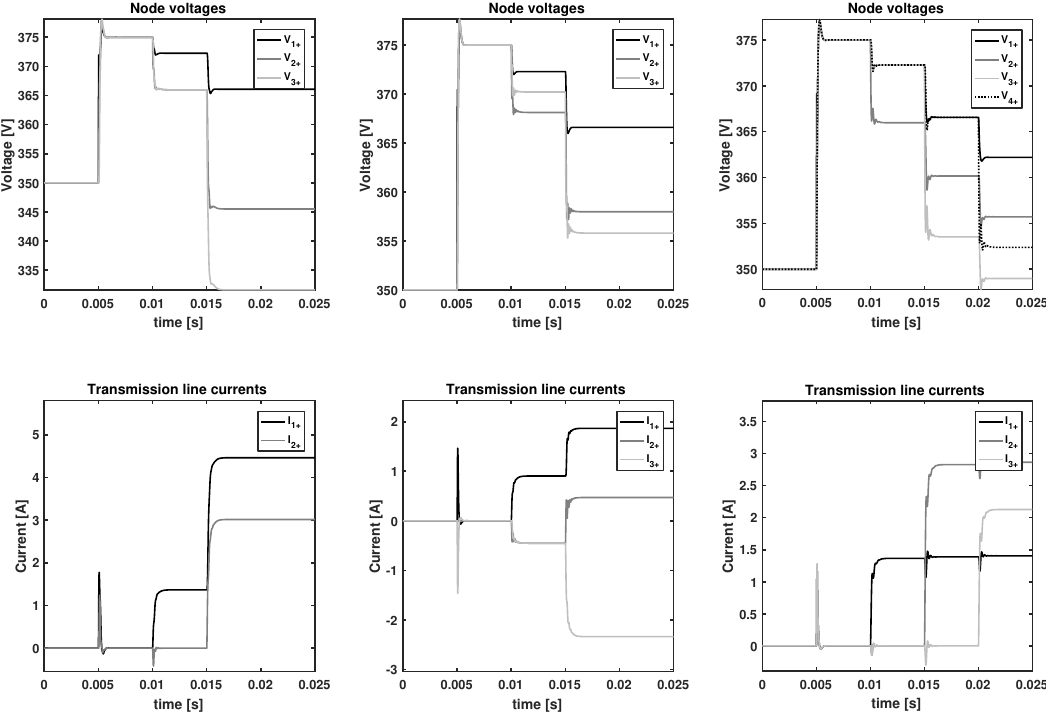
Figure 10. Node voltages and distribution line currents of the bus ( left ), ring ( middle ) and star ( right ) example systems under changing loads and reference voltages, with a droop impedance of 2 Ω